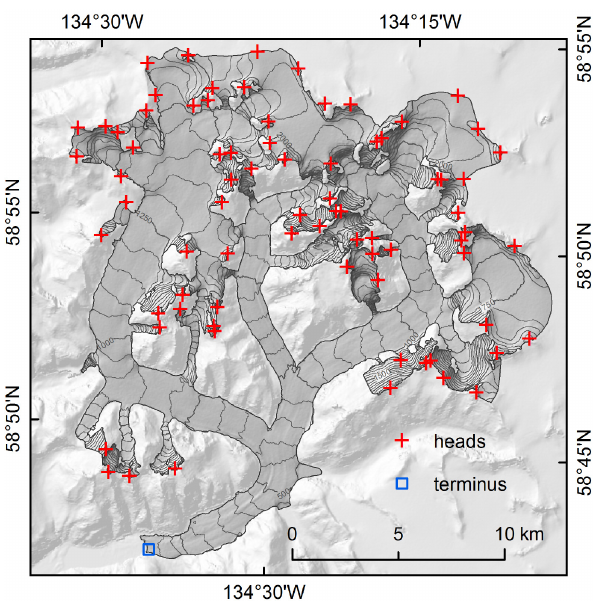
Fig. 2. Automatically derived glacier heads (red crosses) and ter- minus (blue square) on Gilkey Glacier, Juneau Icefield, southeast Alaska. The 50m contours and the shaded-relief background are derived from the SRTM DEM.